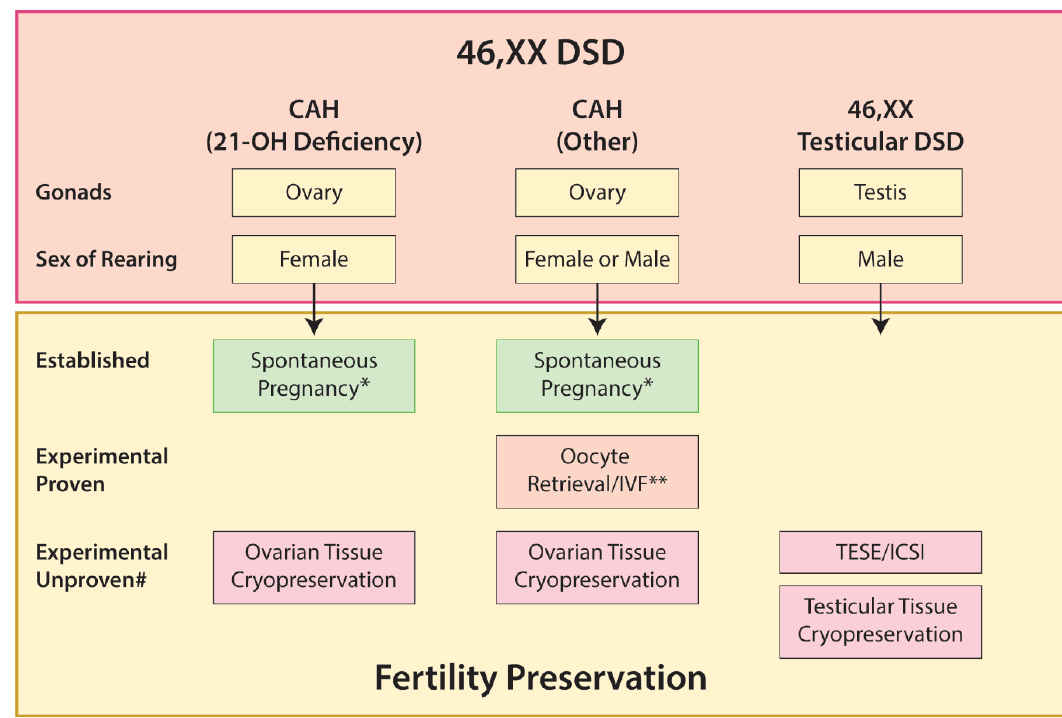
Figure 4. Options for fertility preservation in 46,XX DSD. * Optimise therapy for CAH. ** Postpubertal. # Potential for gonadal tissue cryopreservation based on published literature indicating presence of germ cells +/ − tissue cryopreservation; however, there are no reports of successful restoration of fertility and this should be considered within the context of an ethically approved research